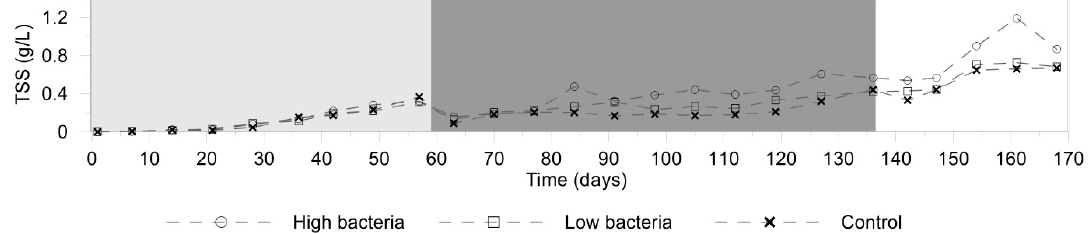
Figure 3. Evolution of total solid suspends. Each data represents the average of the three experimental units for high bacteria treatment (2.8 × 10 4 cfu/mL), low bacteria treatment (2.8 × 10 3 cfu/mL) and control treatment.